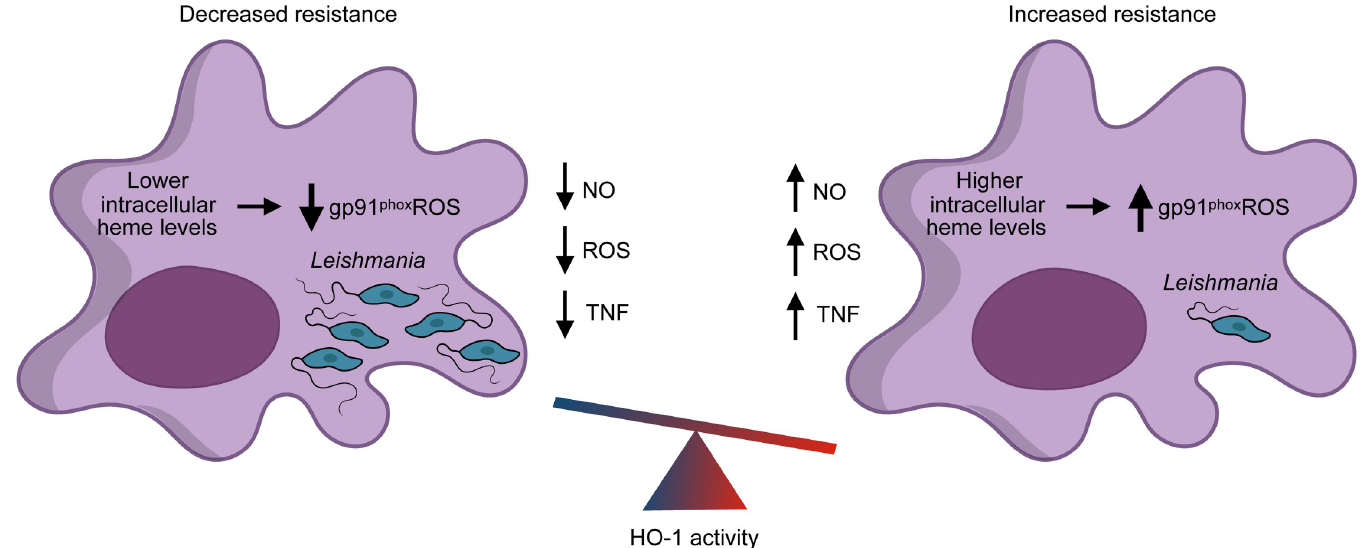
Fig 3. HO-1 on Leishmania sp. Leishmania infection induces HO-1 on macrophages causing a reduction in intracellular levels of heme that affect gp91Phox activity and ROS generation. NO and TNF production are also inhibited by HO-1. Thus, up-regulation of HO-1 expression increases parasitism and disease tolerance. gp91Phox, glycosylated 91-kDa phagocyte NADPH oxidase; HO-1, heme oxygenase 1; NO, nitric oxide; ROS, reactive oxygen species; TNF, tumor necrosis factor.